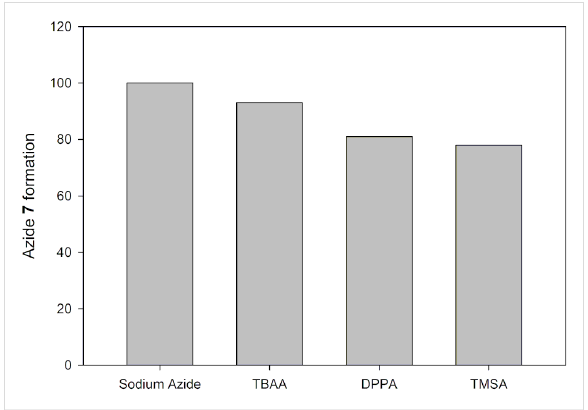
Figure 18: Continuous flow synthesis of azide 7 from acetamide 6 using various azidating